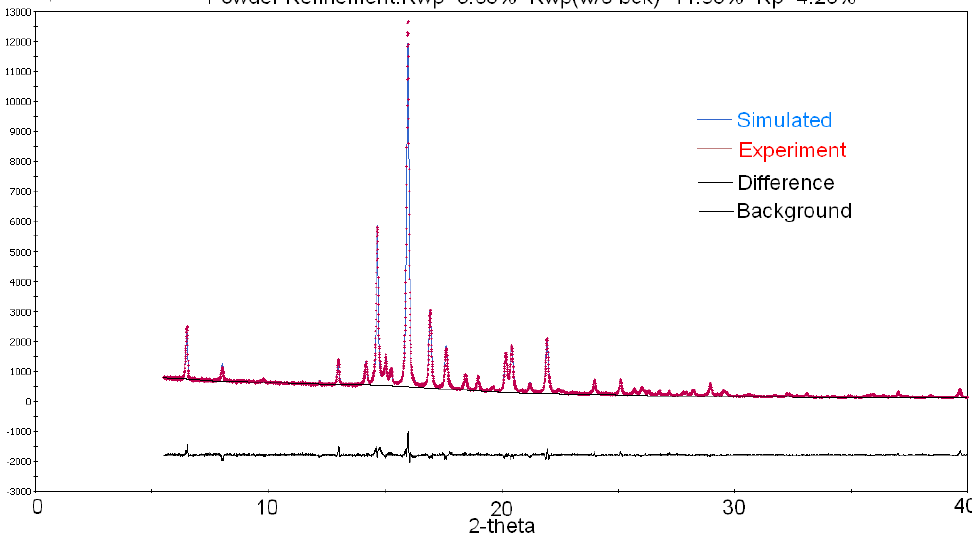
Figure 6. Rietveld refinement and the agreement between simulated and experimental patterns.